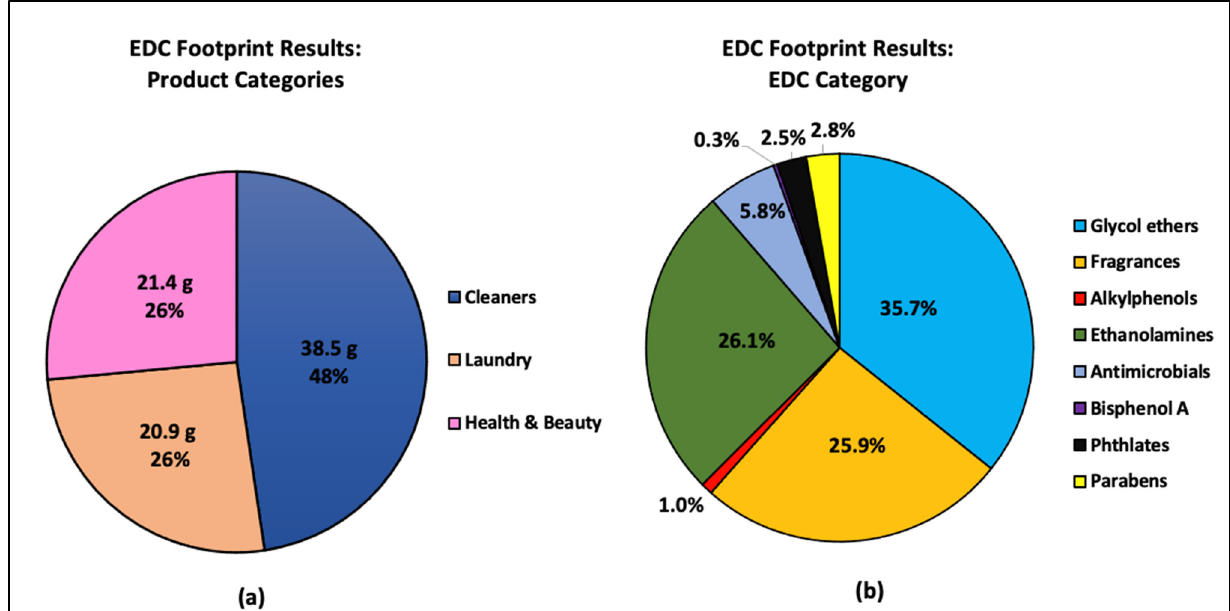
Figure 3. Example of endocrine-disrupting compound (EDC) footprint calculator results for one user with ( a ) the mass and percent contributions of each product category to the total estimated EDC footprint; ( b ) the percent contribution of each EDC to the total estimated EDC footprint.